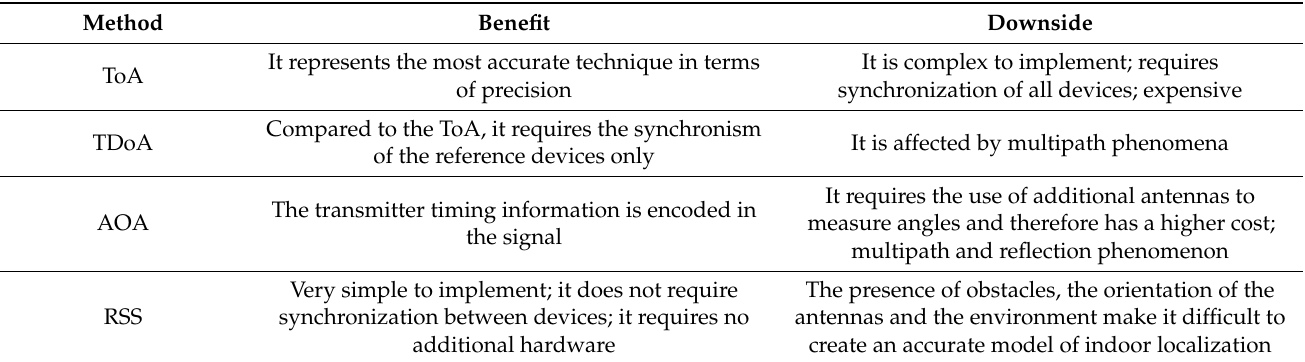
Table 2. Advantages and disadvantages of indoor localization algorithms.